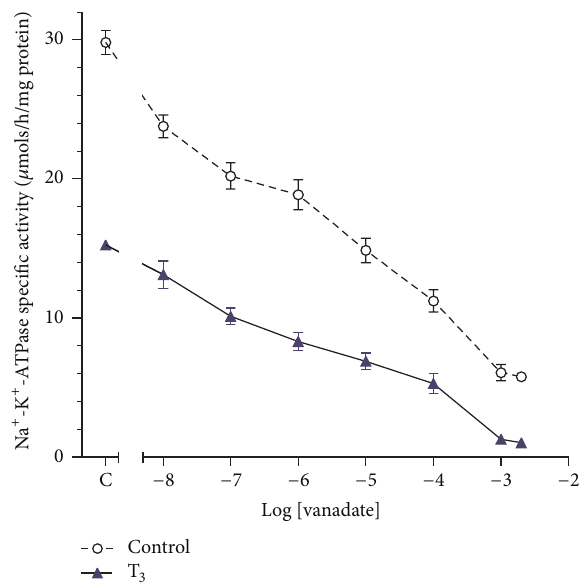
Figure 8: Modulation of the T 3 action on synaptosomal Na + -K + - ATPase activity by sodium orthovanadate. A higher dose of T 3 (10nM) was chosen from the T 3 dose-response curve considering its greater inhibitory action on the Na + -K + -ATPase activity and to observe the effect of graded doses (1nM–2 mM) of sodium ortho- vanadate on this T 3 -induced inhibition. The data are represented as mean ± SEMoffourseparateexperiments,takingsixanimalsineach group. The vertical bars denote SEM. Open circles indicate mean values for a set of control incubations without T 3 . Filled triangles indicate the results of a set of incubations with 10nM T 3